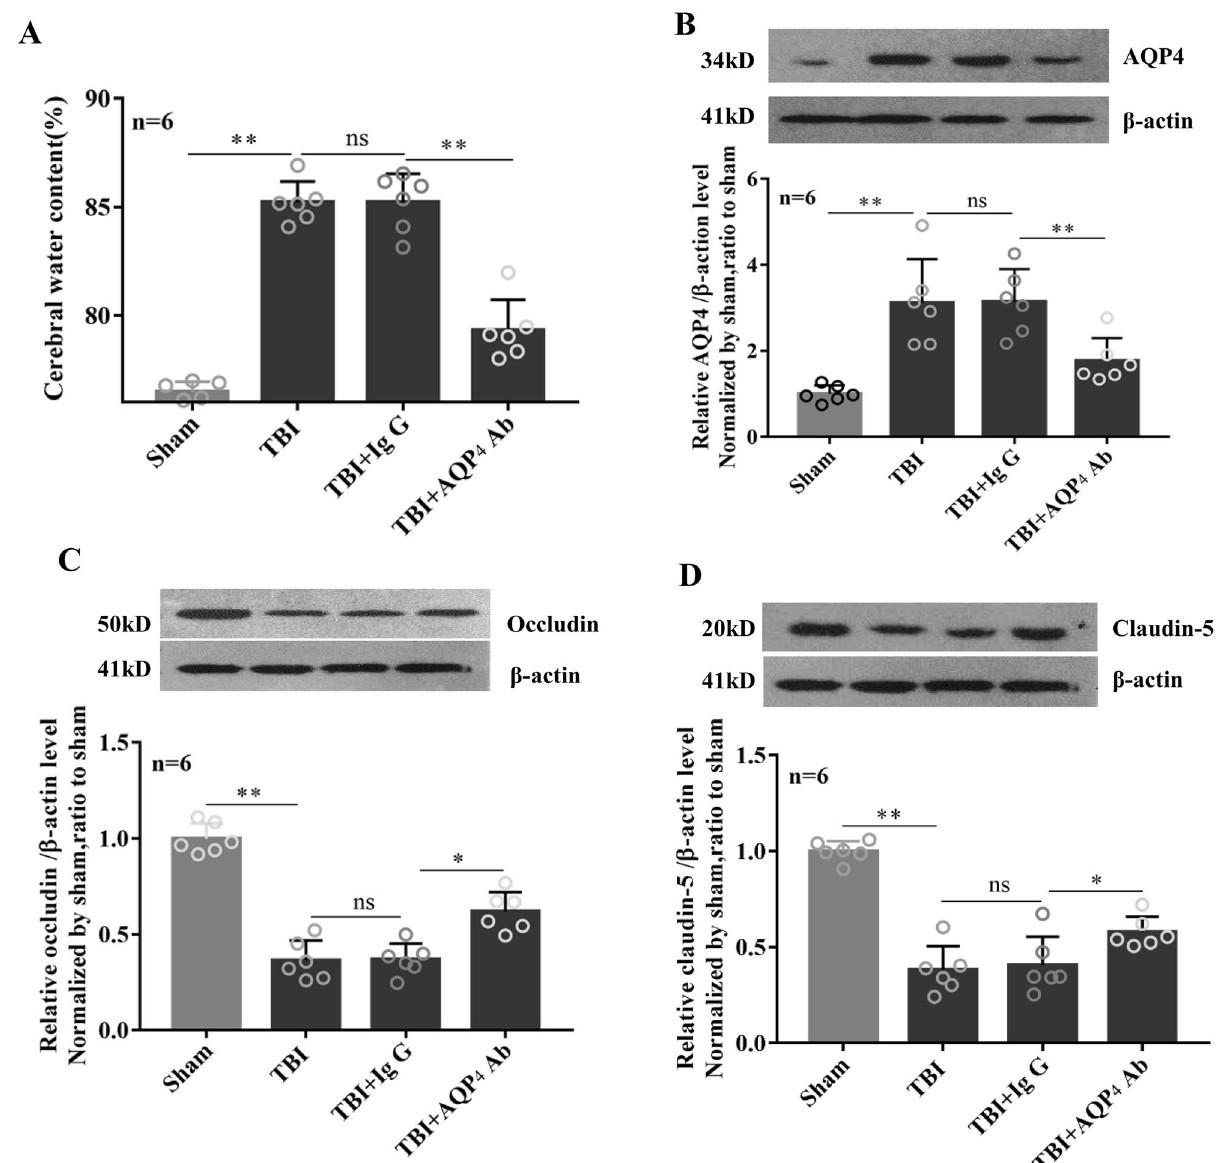
Figure 1. Blockage of AQP4 ameliorated brain edema in the acute phase after TBI. Rats were intravenously injected via the tail vein with 0.25 ml isotonic saline containing neutralized-AQP4 antibody (1 μg/kg of body weight) within 30–60 min after TBI, the control animals were injected with IgG. ( A ) On the 1st day post TBI, brain edema was examined by brain water content. Protein levels of AQP4 ( B ), Occludin ( C ) and Claudin-5 ( D ) were detected by western blot with β-actin as an internal control. The identical internal control β-actin blots were shared for Occludin and Claudin-5 blots because the detections were performed on the same blot membrane. Data are expressed as mean ± SEM, n = 6 per group. The comparisons among groups were analyzed by one-way ANOVA and the least significant difference (LSD) method. * P < 0.05, between the two groups. ns